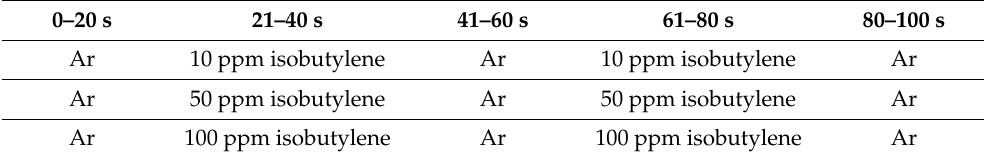
Table 1. Gas concentration in isobutylene cycle test.